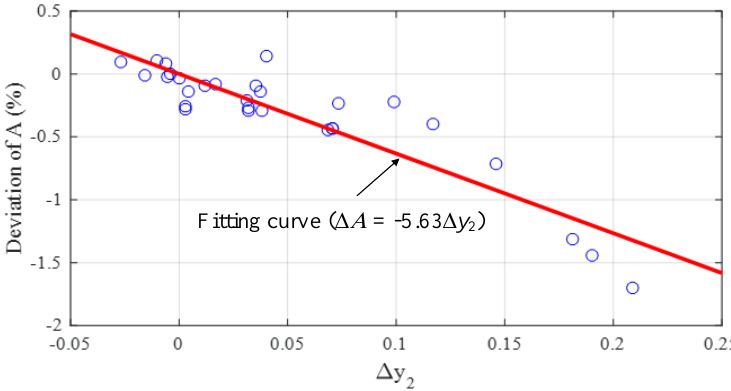
Figure 5. Deviation of A versus the undershoot factor ( D y 2 ) and the fitted curve.